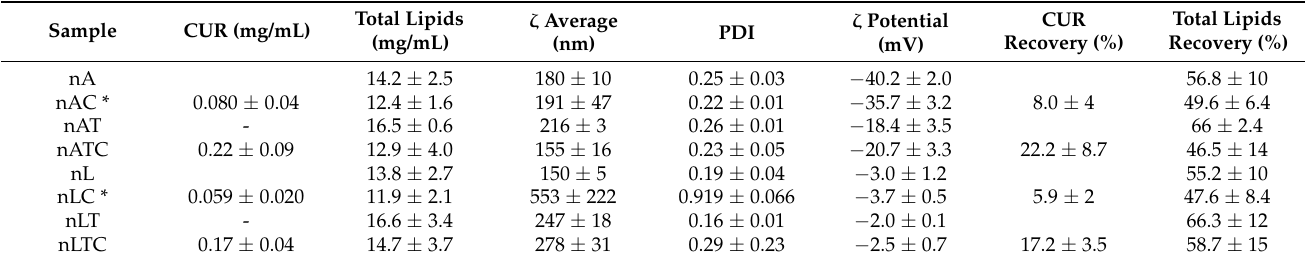
Table 1. Structural features of void and CUR-loaded nanovesicles. Results are the media of 6 lotes. * n = 2.